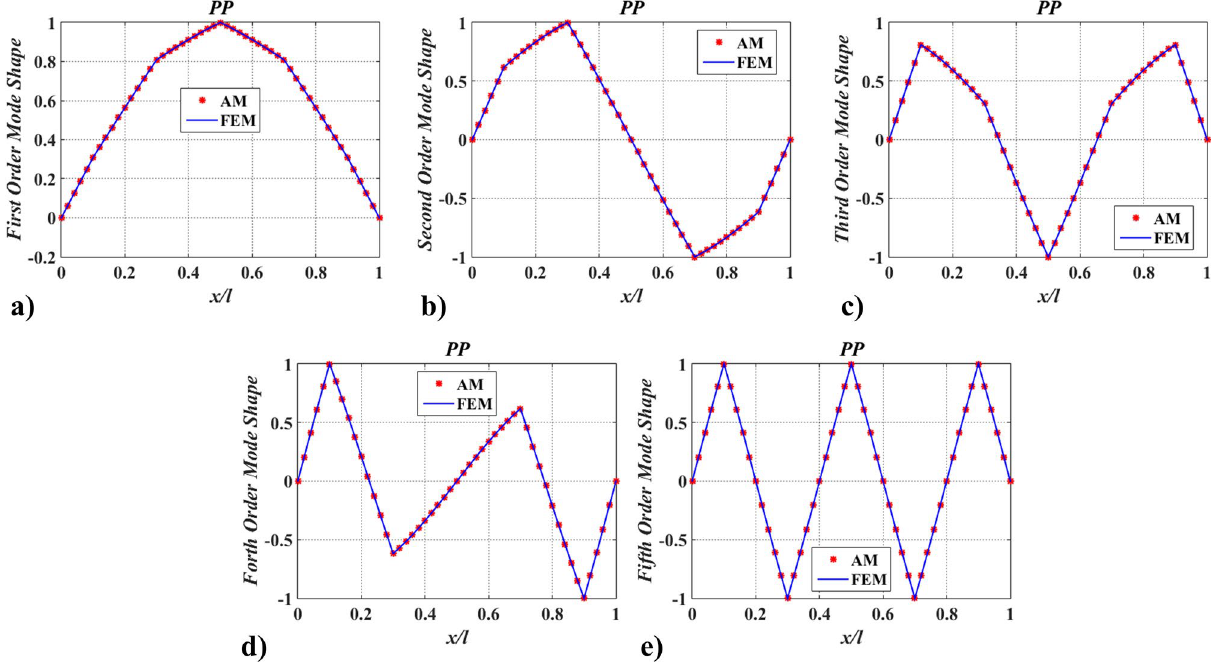
Figure 10. The lowest five mode shapes of twisting angles for the shaft carrying five concentrated elements in the PP support conditions obtained from FEM and AM (small number of discrete points).